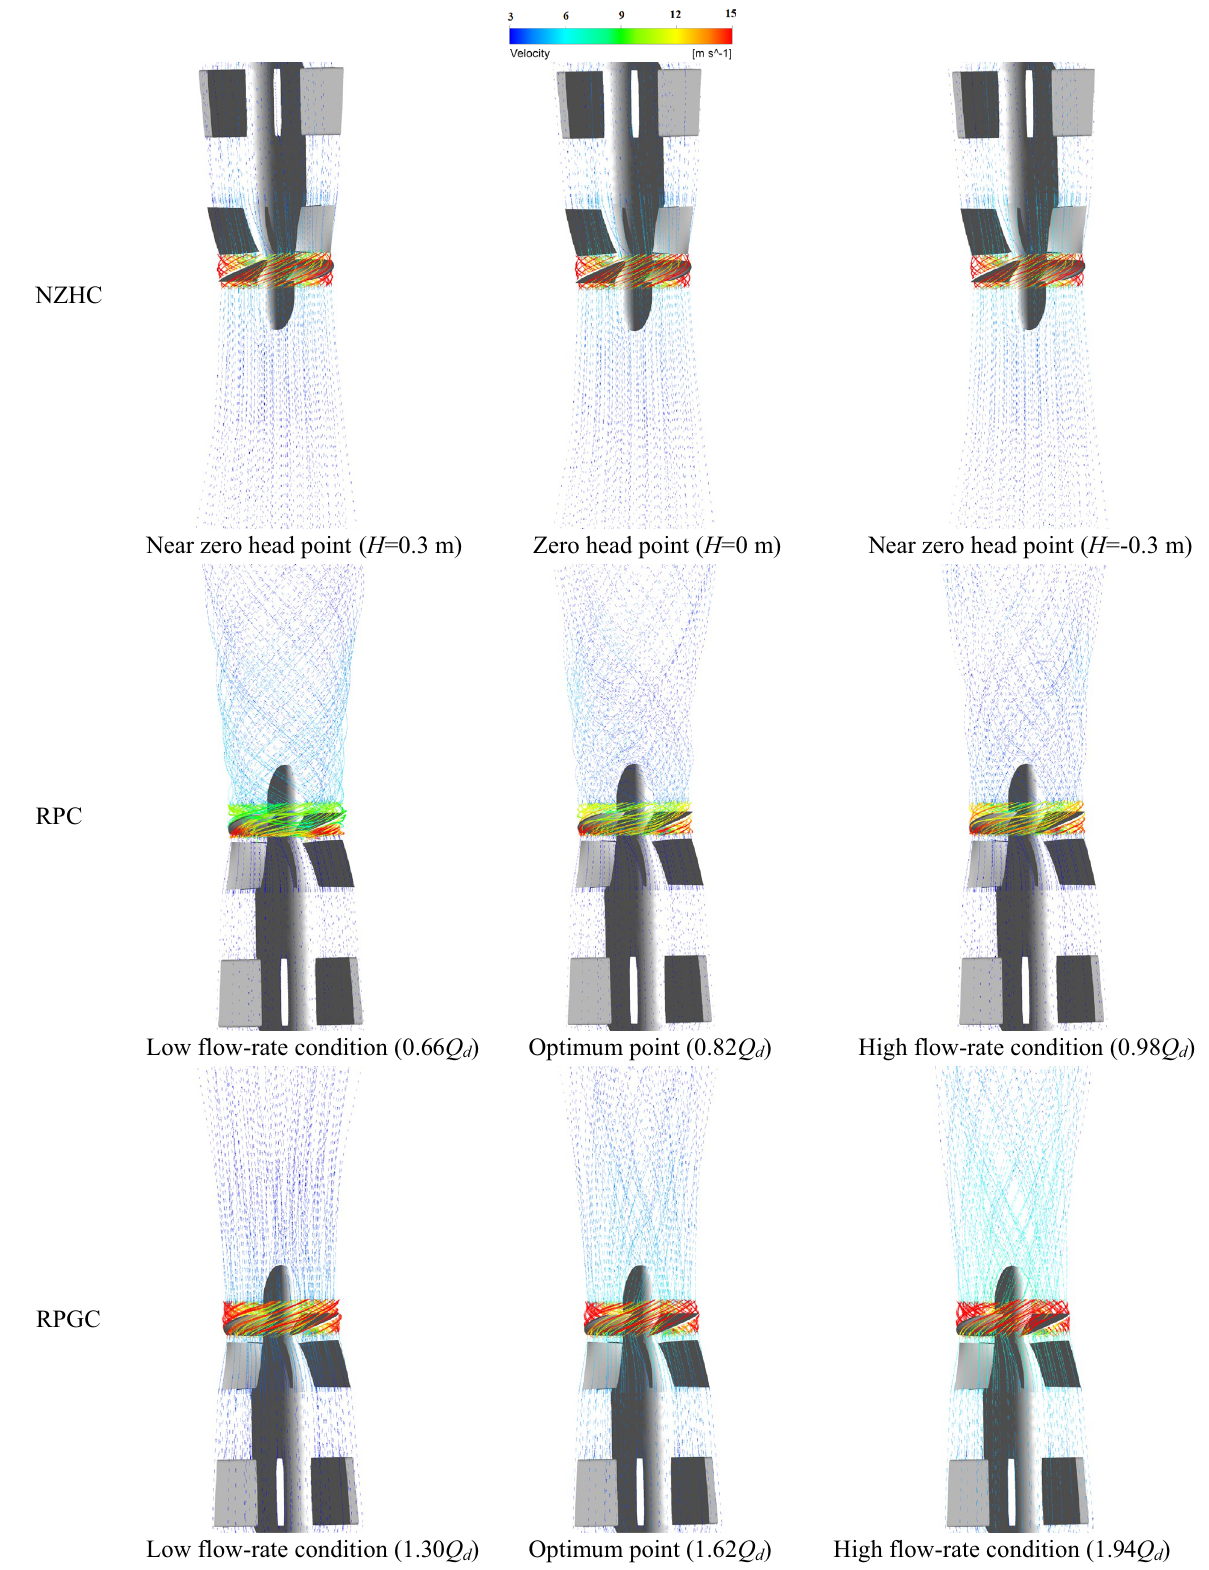
Figure 24. Internal flow line of the pump system under special utilization